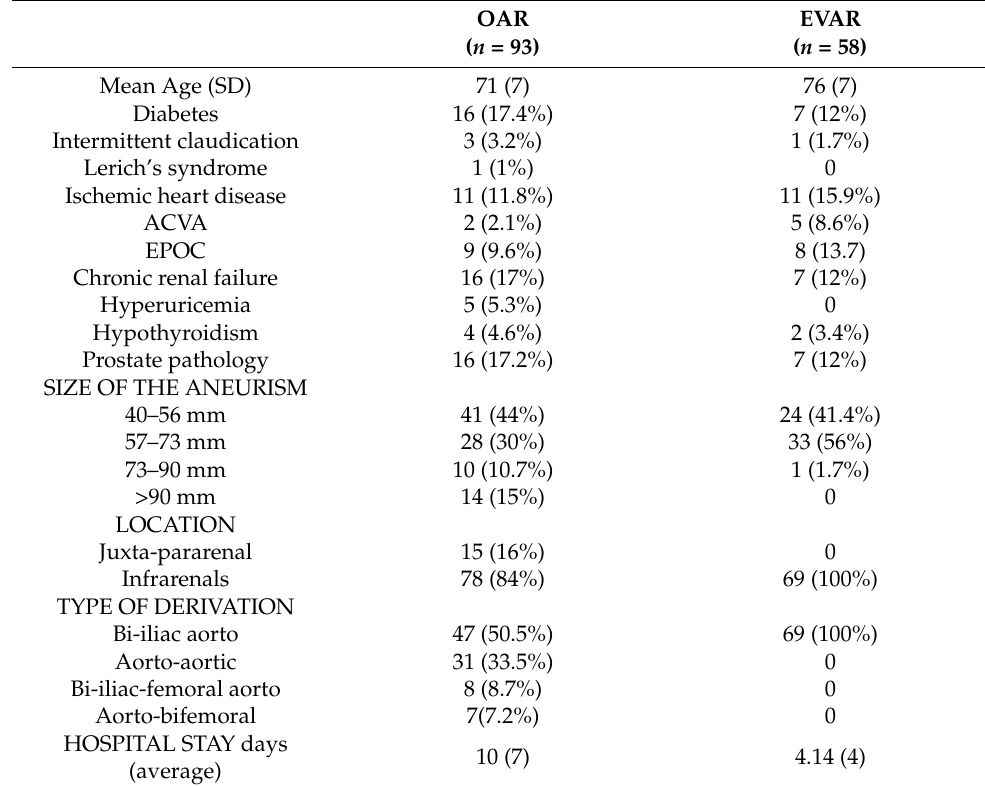
Table A1. Characteristics of the operated patients and associated pathologies.